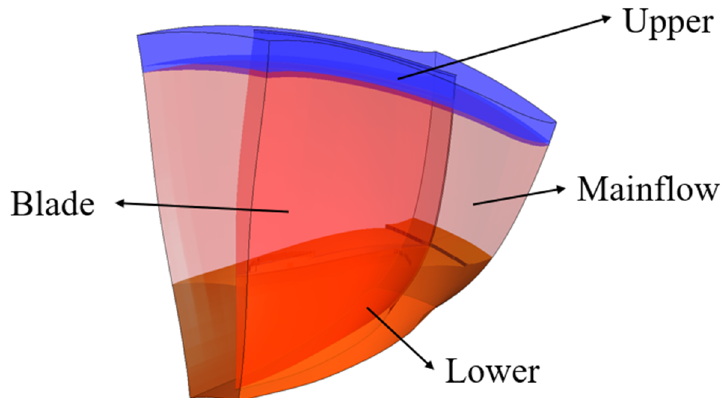
Figure 13. Schematic drawing of control volumes.